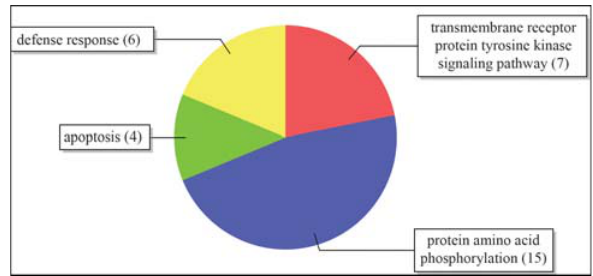
Figure 4 - Distribution of GO terms in the Biological Process category, level 3.